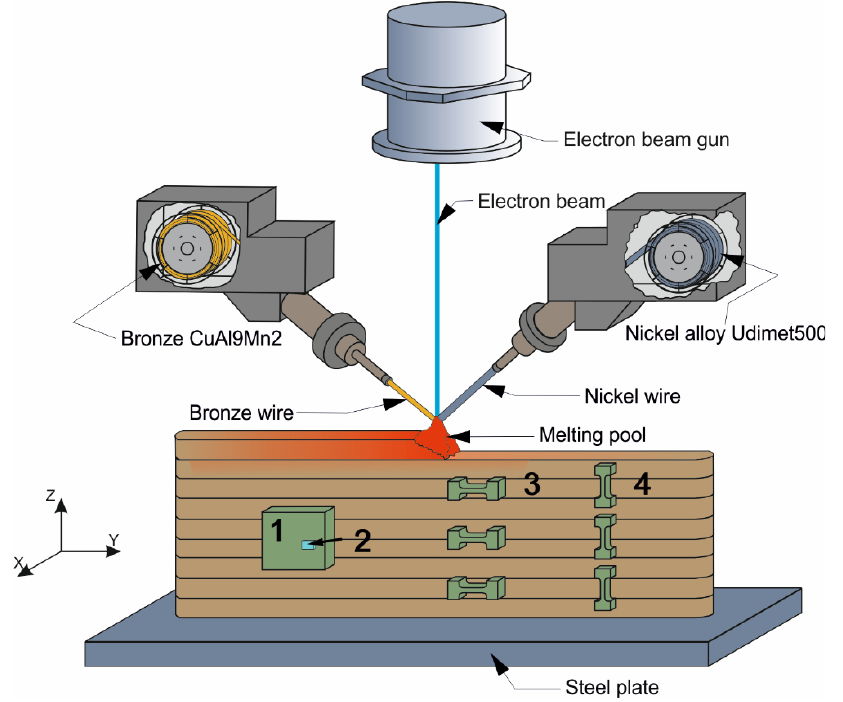
Figure 1. Schematic diagram of double-wire-feed electron-beam additive manufacturing. 1—samples for examination using optical microscopy, XRD and SEM; 2—thin foils for TEM; 3, 4—samples for mechanical testing.